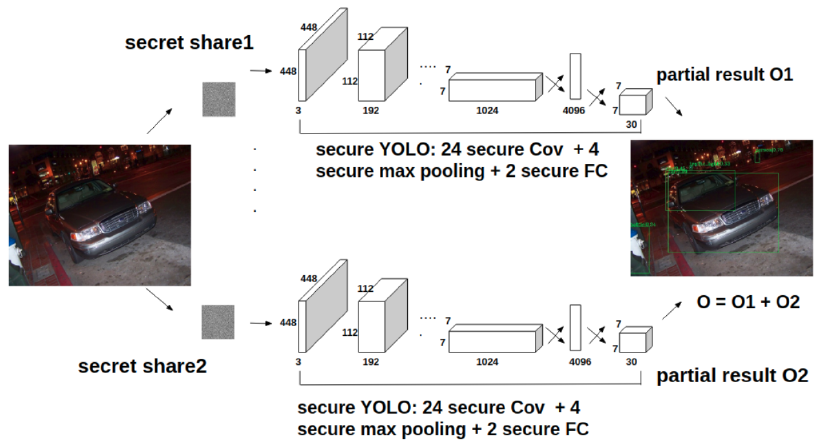
Figure 3. Structure and major components of vePOD YOLO. Image-level secret sharing is applied. Edge servers execute secure functions in vePOD YOLO to process secret shares.